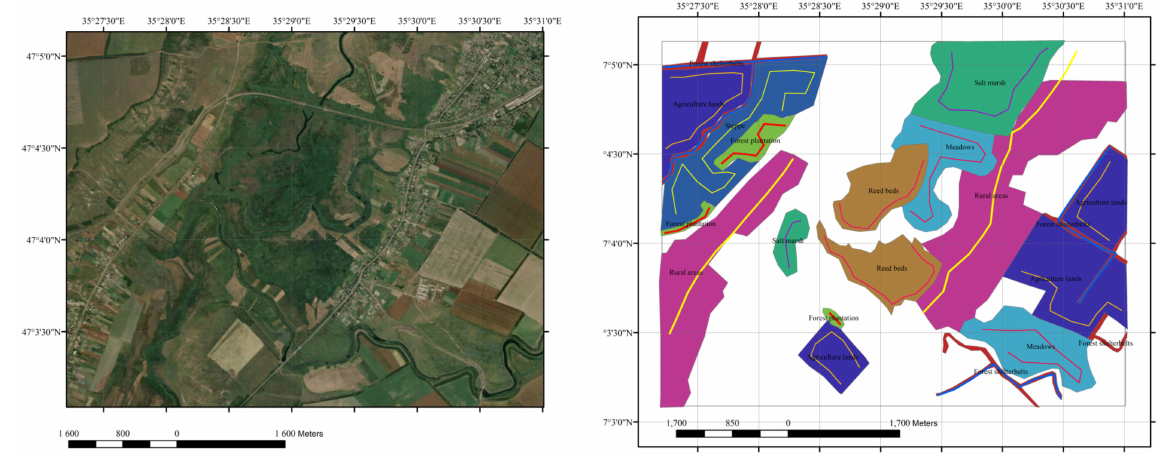
Figure 1. Types of biotopes within the area studied and survey